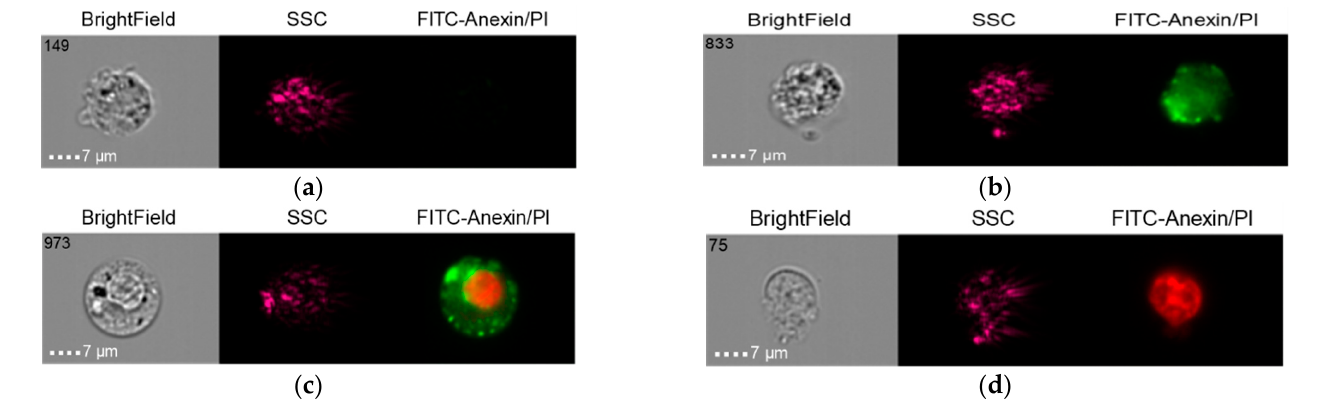
Figure 12. Live cells ( a ), early apoptosis ( b ), late apoptosis ( c ), necrosis ( d ) after co-culture of Alpha Bio NSMP with THP-1 cell line (Alpha Bio NSMP + DSP + LPS